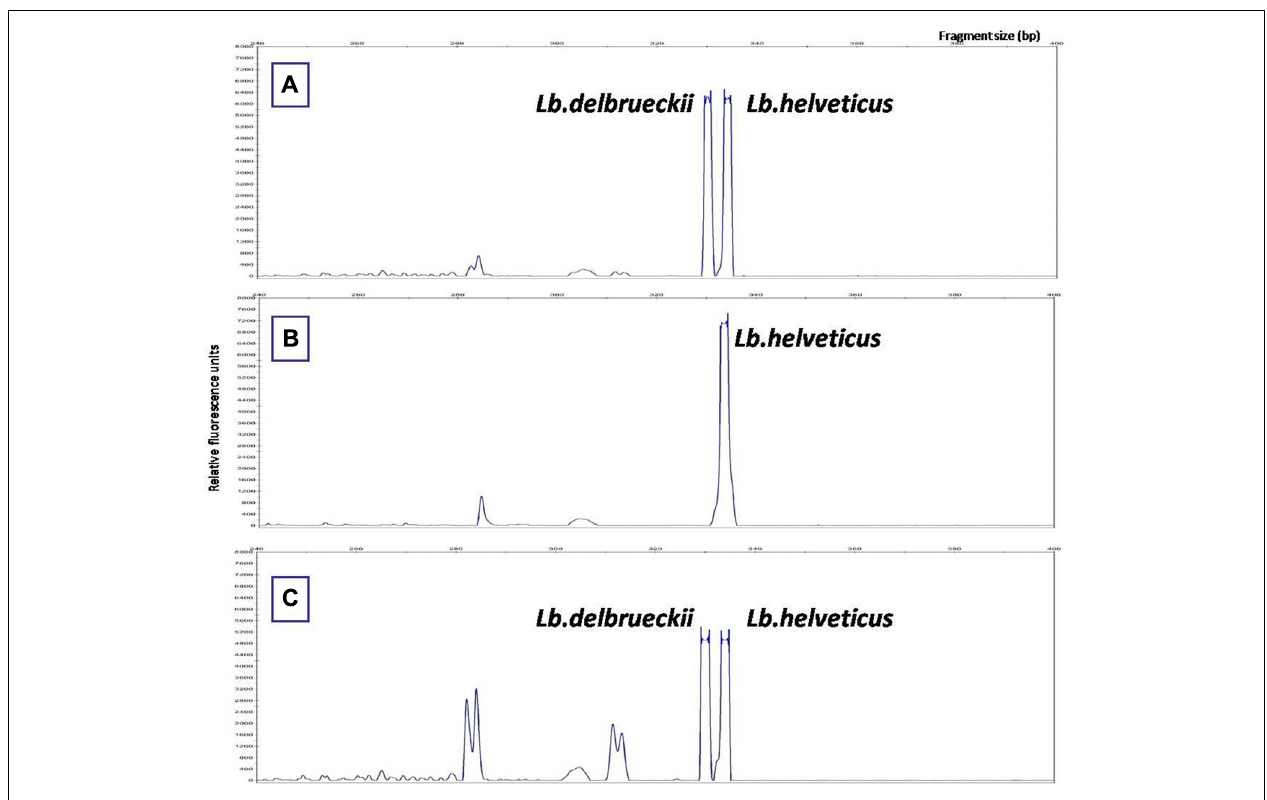
FIGURE 2 | Microbial profiles of PR natural whey starters revealed by length heterogeneity-PCR: (A) Presence in comparable percentages of Lb. helveticus and Lb. delbrueckii , (B) presence of Lb. helveticus as the dominant species, (C) presence of Lb. helveticus and Lb. delbrueckii percentages comparable to the percentages of other